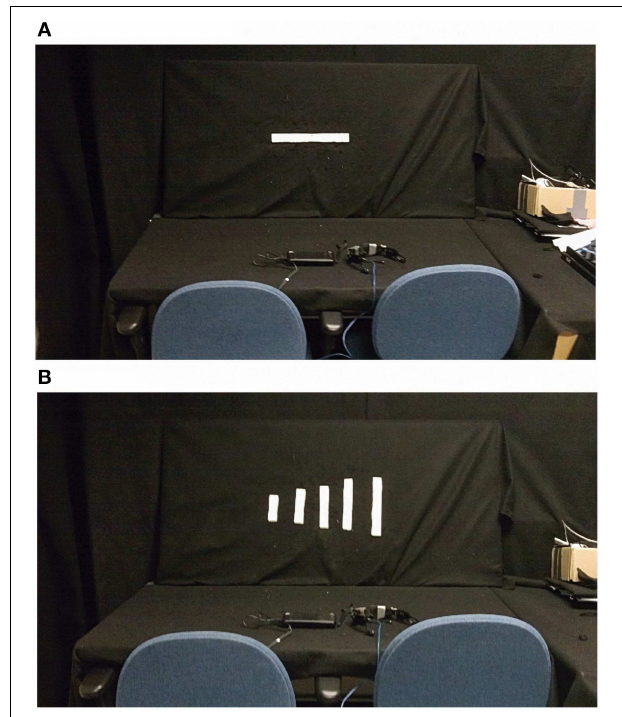
FIGURE 1 | Experimental Setup. (A) Shows the experimental setup for the orientation constancy task (classification of line orientation angle independent of head tilt; the horizontal line shown is 90 ◦ ). To perform the orientation constancy task, the subject sits in the right chair and determines the angle of the line placed on the board in one of six orientations (vertical, horizontal, − 22, 22, − 45, and 45 ◦ relative to the vertical; 6AFC). (B) Shows the experiment setup for the length constancy task (classification of line length independent of line orientation angle). To perform the length constancy task, the subject sits in the right chair and determines the length of the line placed on the board in one of four orientations (vertical, horizontal, − 45, and 45 ◦ relative to the vertical; 5AFC) (during each task only one bar is placed on the